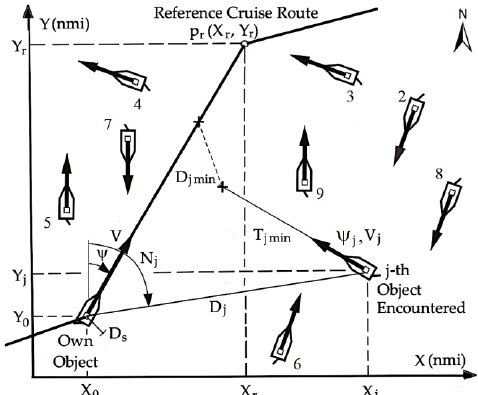
Figure 1. Displaying the situation of passing own object with multiple objects, in particular with the j-th object: X